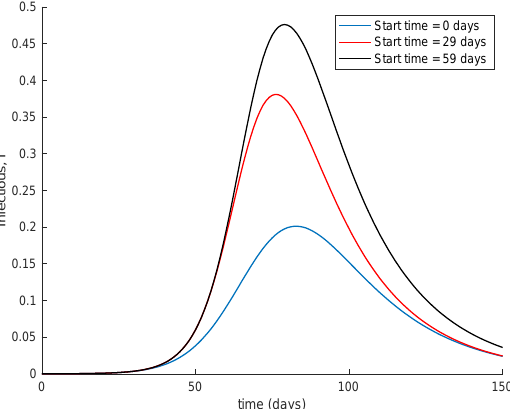
Figure 3. Effect of vaccination starting time on the infectious.